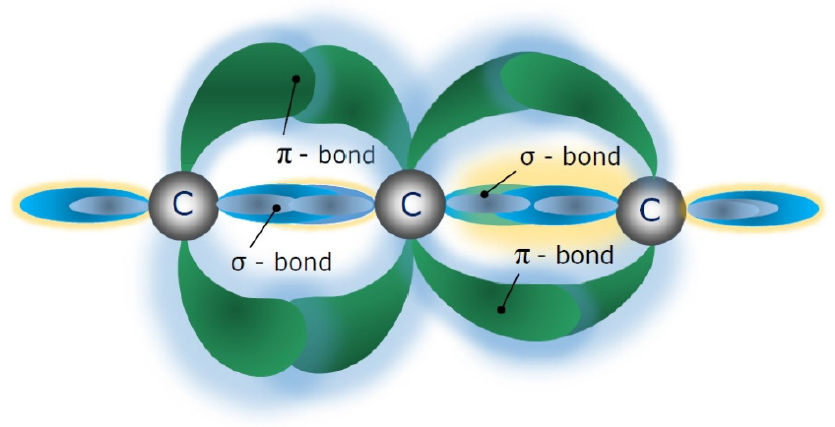
Figure 1. The electronic configuration of a fragment of a linear-chain carbon molecule.